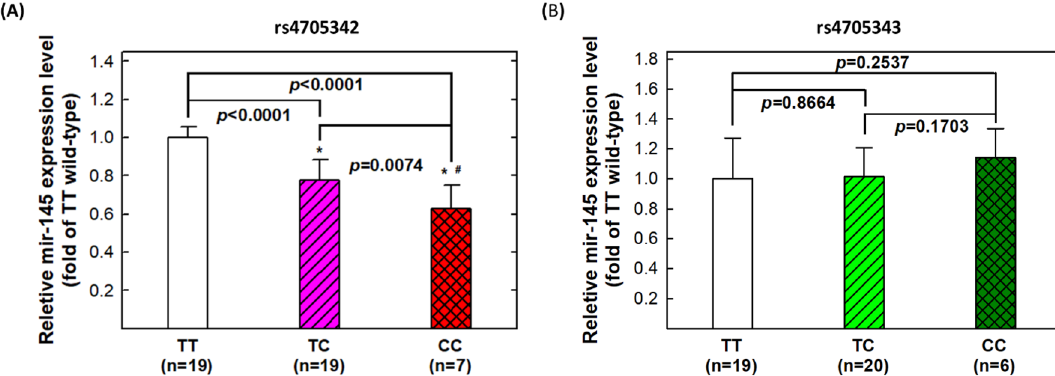
Figure 1. Correlation between rs4705342 and rs4705343 genotypes and miR-145-5p expression in the serum of non-asthmatic healthy subjects. ( A ) MiR-145-5p expression levels of 45 healthy samples according to rs4705342 genotypes; ( B ) MiR-145-5p expression levels of 45 healthy samples according to rs4705343 genotypes. *Statistically significantly different from TT genotypes; # statistically significantly different from TC